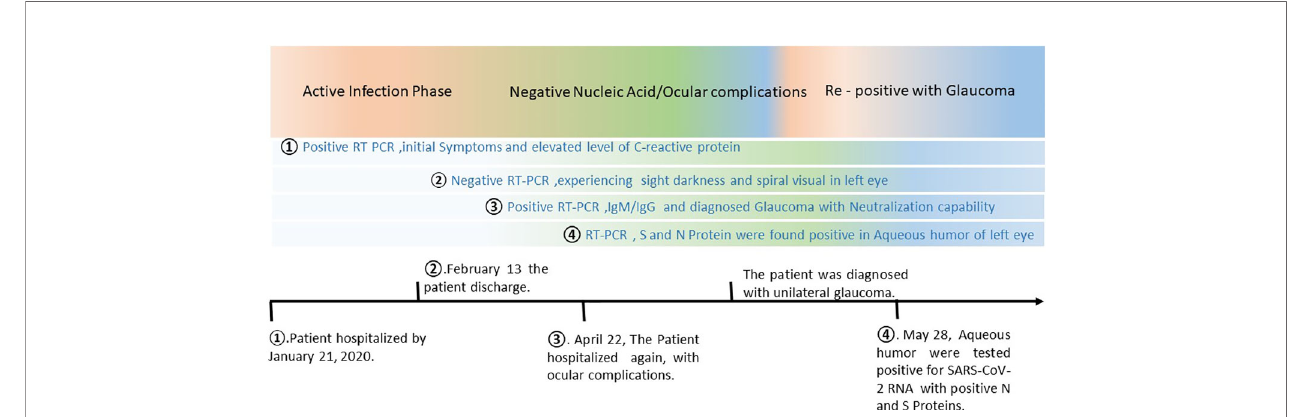
FIGURE 2 | Timeline of the COVID-19 infection, development of glaucoma, and recurrence SARS-CoV-2. On January 21, 2020, the patient was presented to the Hubei provincial hospital of Traditional Chinese Medicine with initial COVID-19 signs and symptoms and eventually con fi rmed to be positive for SARS-CoV-2 infection using RT-PCR. After normal recommended medication, the patient was discharged from the hospital on February 13, when declared negative with RT-PCR twice as per hospital criterion. However, the patient was experiencing sight darkness and spiral visual fi eld in her left eye. On April 22, 2020, the patient was re-hospitalized displaying more severe unilateral ocular complications. With an extensive investigation the patient was found re-positive for SARS-CoV-2 with neutralizing antibodies. The ocular complication resulted in unilateral glaucoma. The investigation team further examined the patient closely, and the immunocytochemical study of both eyes was conducted on May 28, 2020. SARS-CoV-2 spike (S) or Nucleocapsid (N) protein were detected in aqueous humor of the left eye